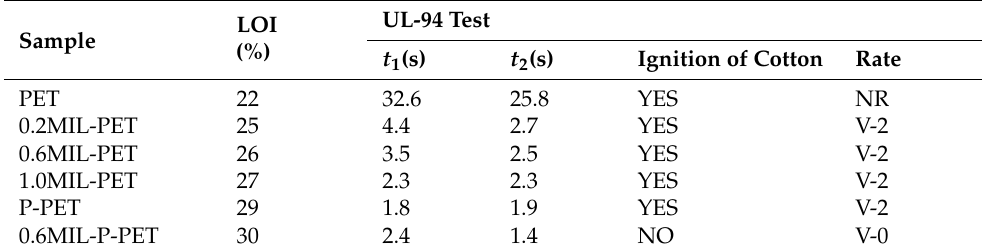
Table 3. Results of LOI and VFT tests for MIL-PET and MIL-P-PET composites.